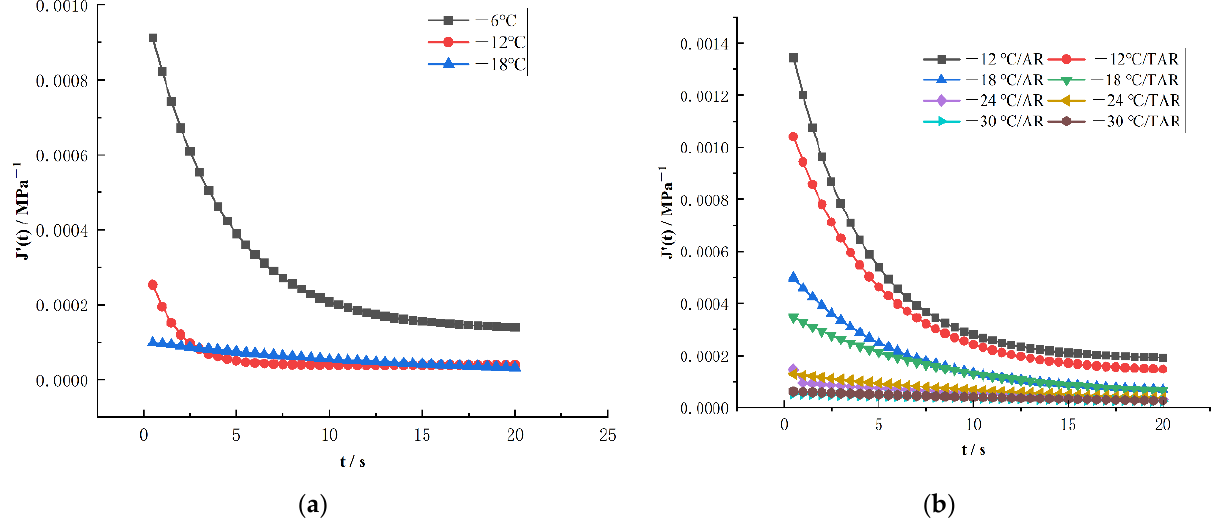
Figure 22. The variations of J ’ (t) at different temperatures. ( a ) JZ ( b ) AR and TAR.